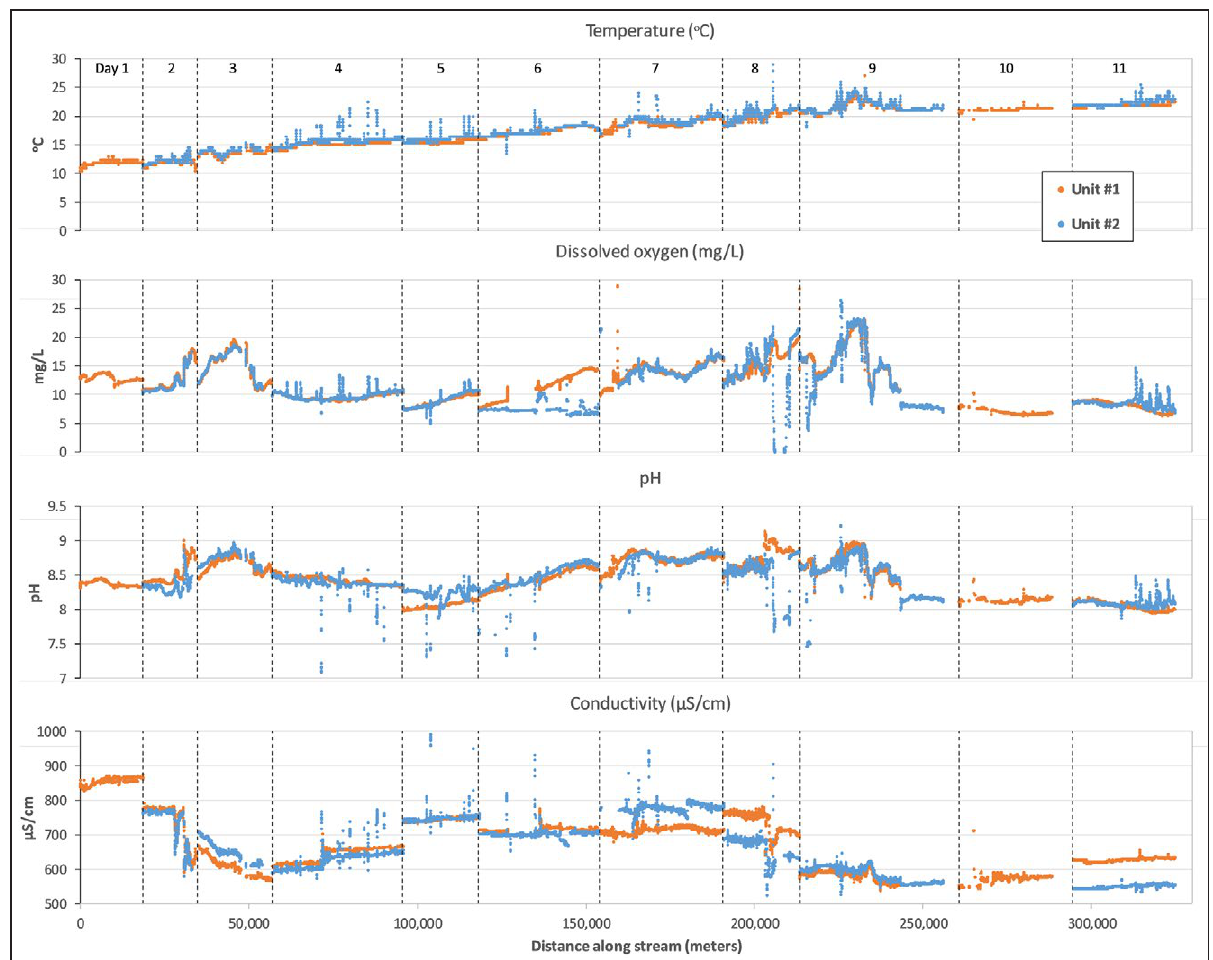
Figure 8: Profile of sample values (n = 30,264) along stream centerline for both devices along Rock River, Wisconsin, for Testing the Waters event. Vertical bars represent each sample day during the event (refer to Figure